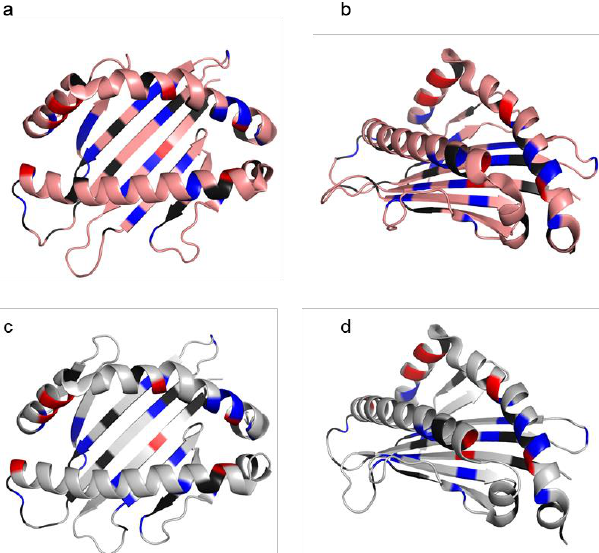
Figure 4. Schematic crystal structure of the human HLA-A*02:01 (PDB code 3MRE) and Ctid- Figure 4 . Schematic crystal structure of the human HLA-A*02:01 (PDB code 3MRE) and Ctid-UAA (PDB code 5H5Z) peptide binding groove defined by the α1 and α 2 domains. HLA -A*02:01 struc- UAA (PDB code 5H5Z) peptide binding groove defined by the α 1 and α 2 domains. HLA-A*02:01 ture ( a , b , pink) and Ctid-UAA structure ( c , d , grey) with similar residues from the sequence of rep- structure ( a , b , pink) and Ctid-UAA structure ( c , d , grey) with similar residues from the sequence of resentative Asian seabass MHC-I residues mapped viewed from the top ( a , c ) and the PΩ side ( b , d ). Black indicates similar residues that were probably found before the molecular evolution of MHC representative Asian seabass MHC-I residues mapped viewed from the top ( a , c ) and the P Ω side classes I and II, blue indicates similar residues that are common in classical MHC-I, and red indicates conserved binding residues in classical MHC-I. ( b , d ). Black indicates similar residues that were probably found before the molecular evolution of MHC classes I and II, blue indicates similar residues that are common in classical MHC-I, and red indicates conserved binding residues in classical